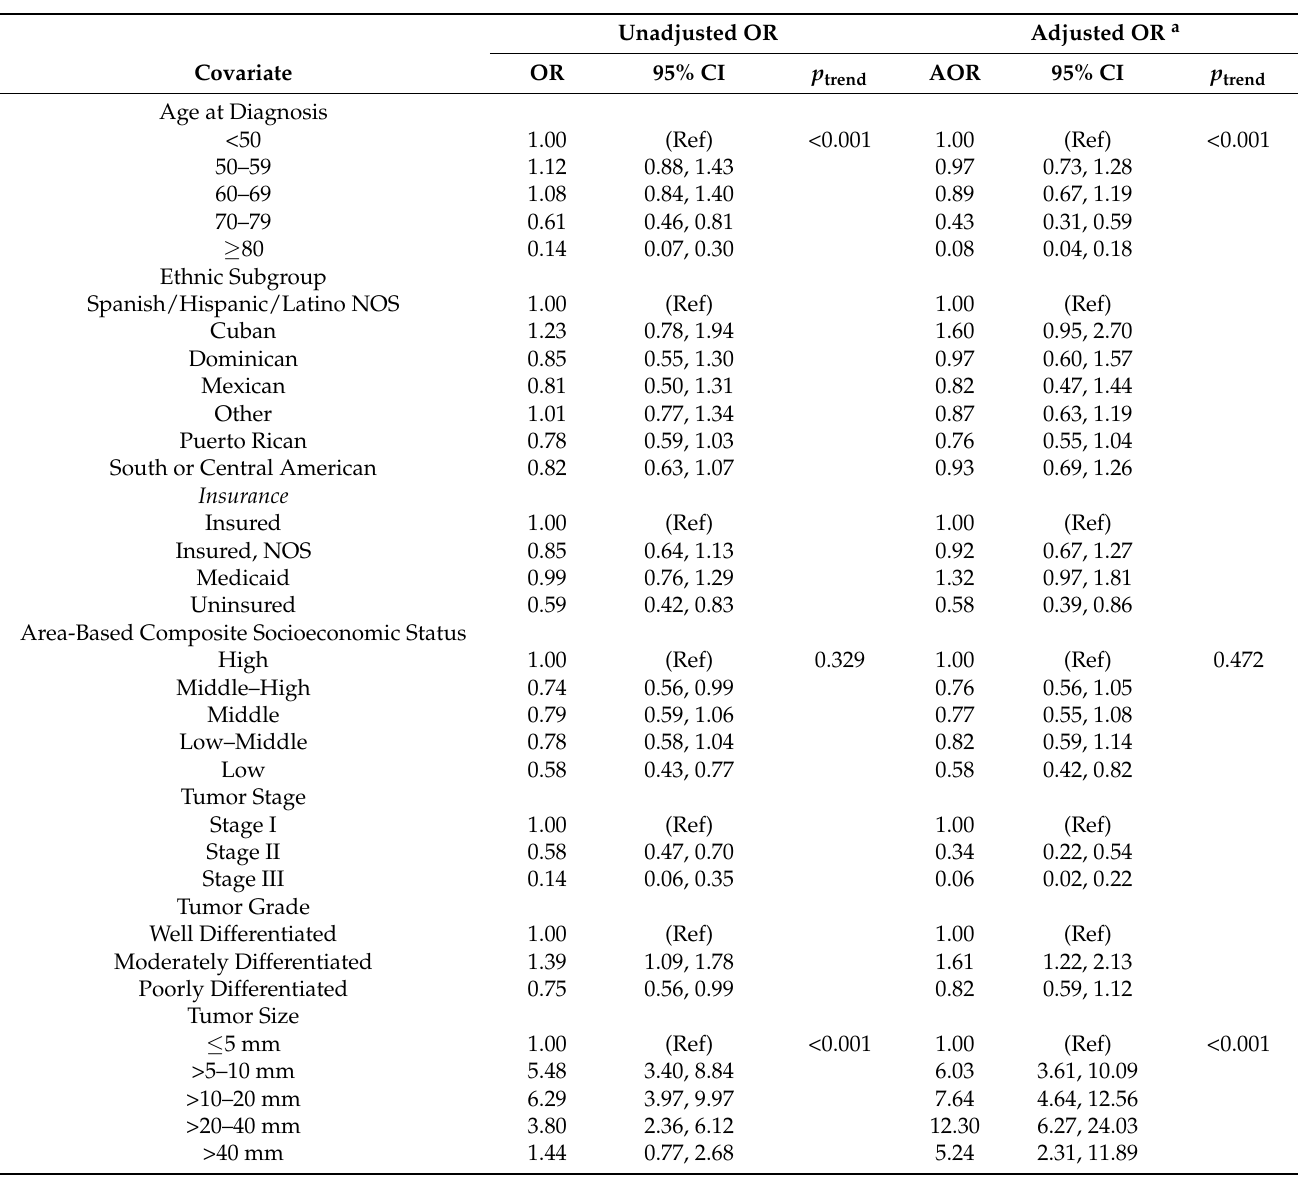
Table 3. Logistic regression analysis of Oncotype Dx test receipt among Latina/Hispanic breast cancer cases who were eligible for the test in New Jersey,